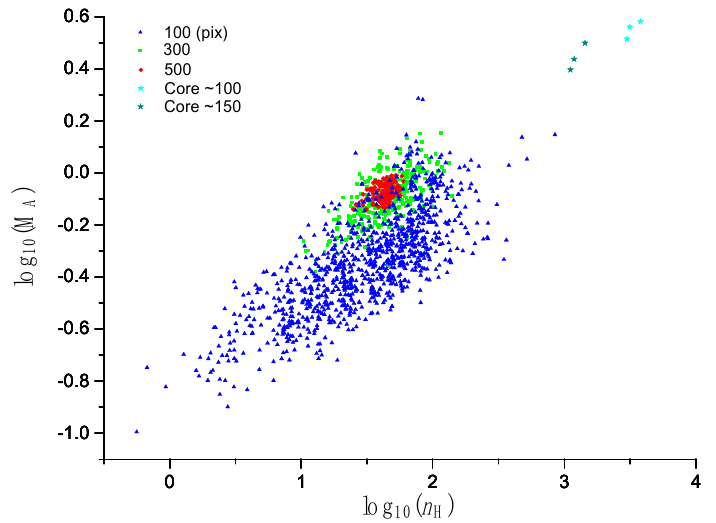
Figure 4. Alfvén Mach number versus density at various scales (100-, 300-, and 500-pixel; 500 pixels is equivalent to 2.4 pc in the simulation) from the same MHD cloud simulation in Figure 3 [12]. The simulation cube is fully and evenly sampled by sub-cubes of various sizes, and the M A and mean density of each sub-cube are plotted. The properties of the three dense cores at 100- and 150-pixel scales are also noted.